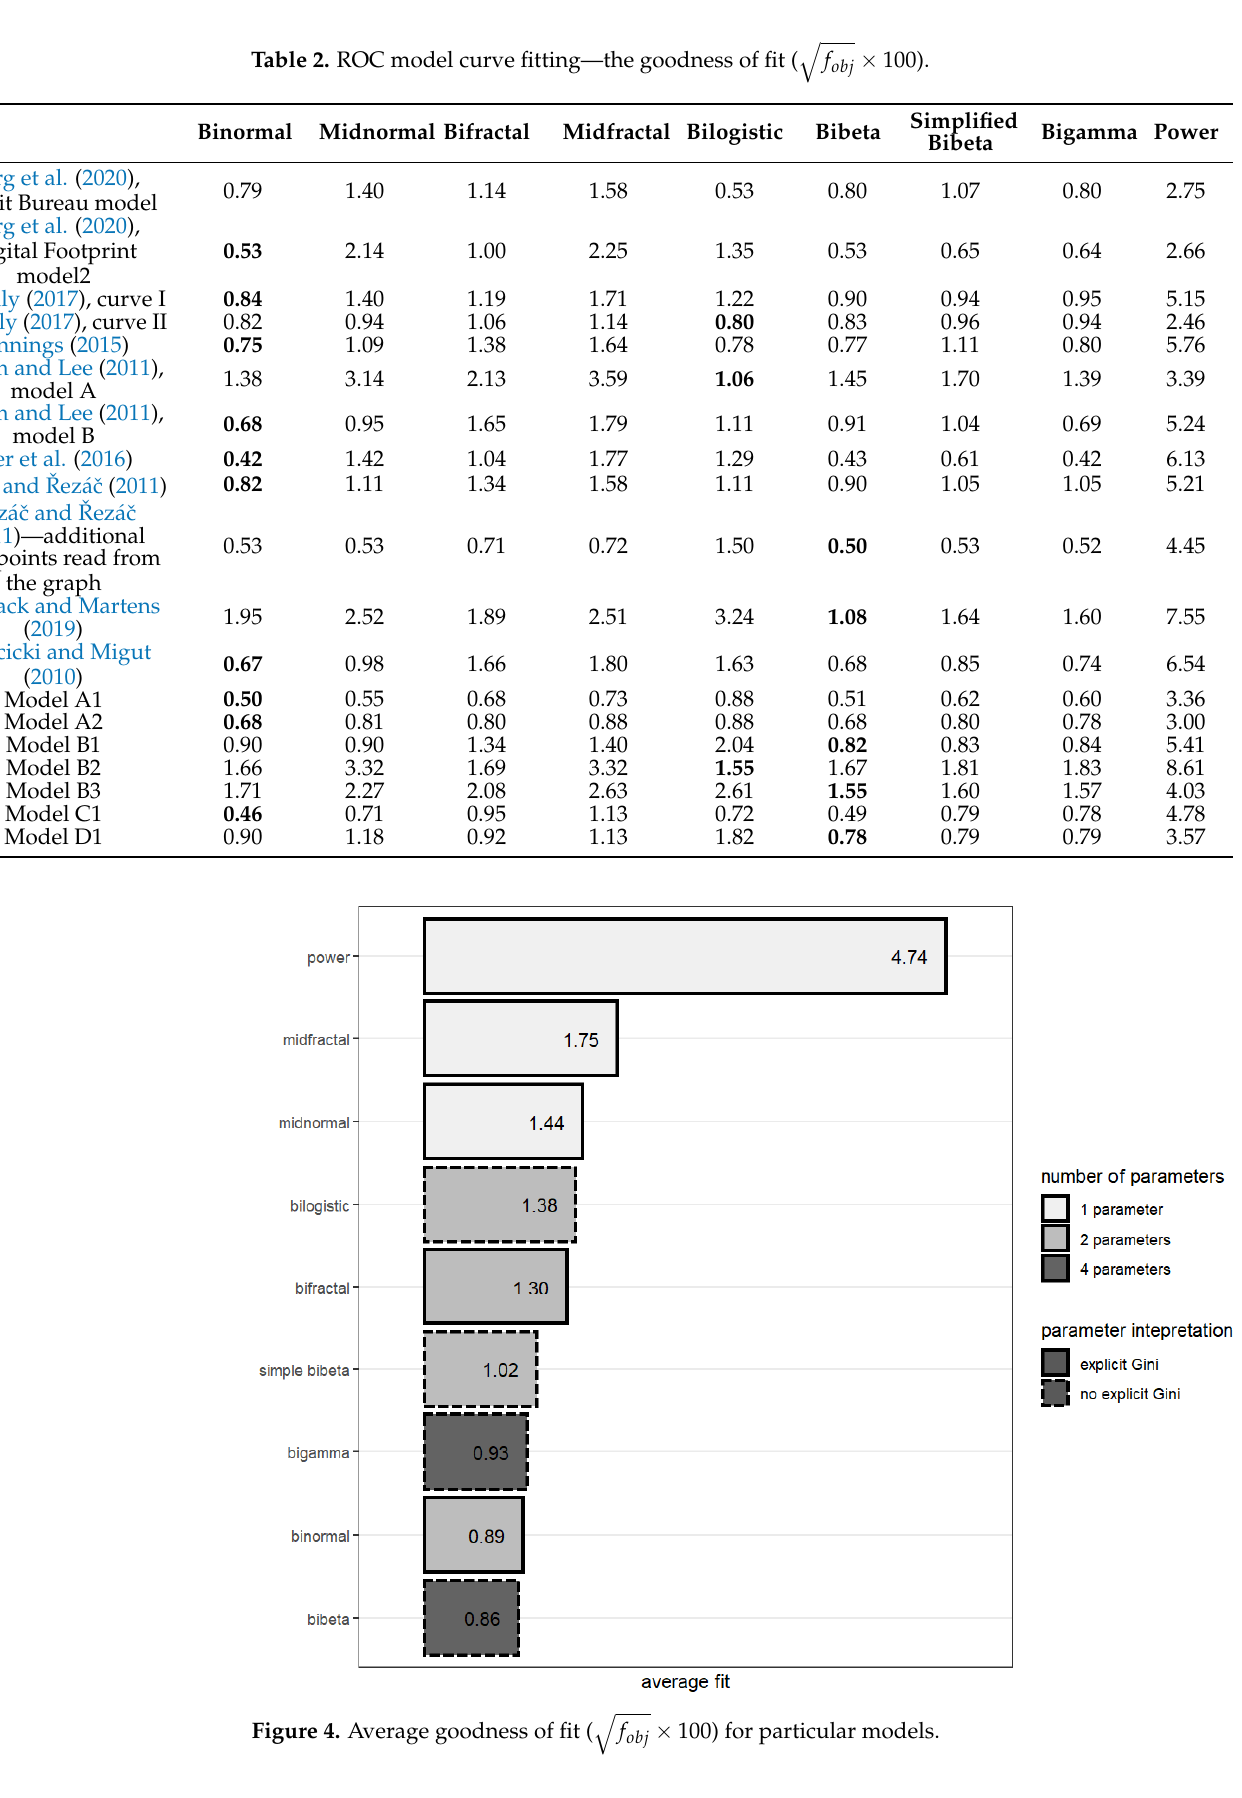
(cid:113) f obj × 100).